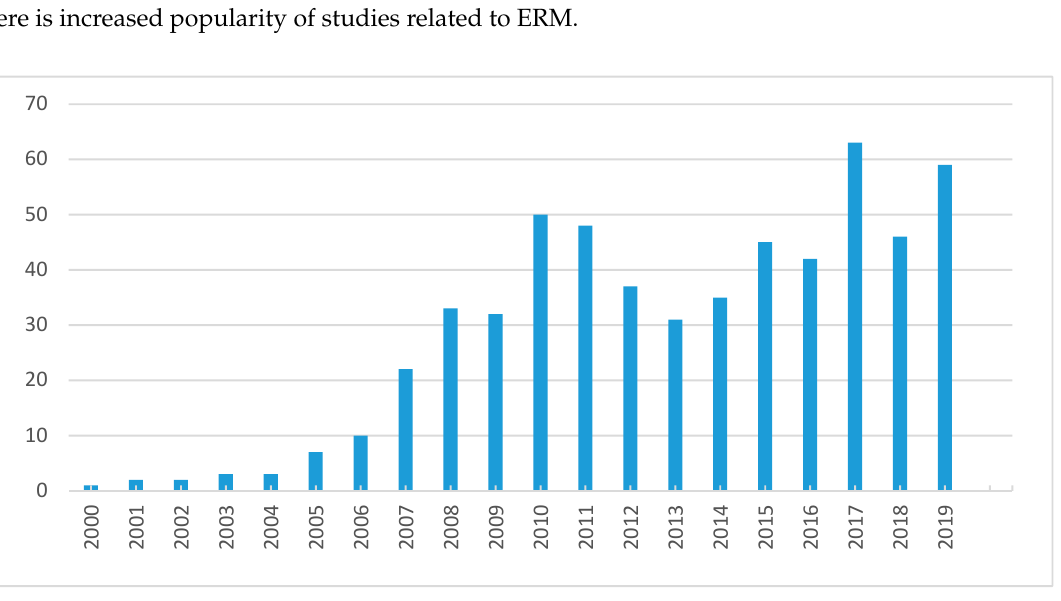
Figure 1. Results of ISI Web of Science search for “Enterprise Risk Management” in the title for the period 2000–2019 (number of publications). Source: Web of Science database